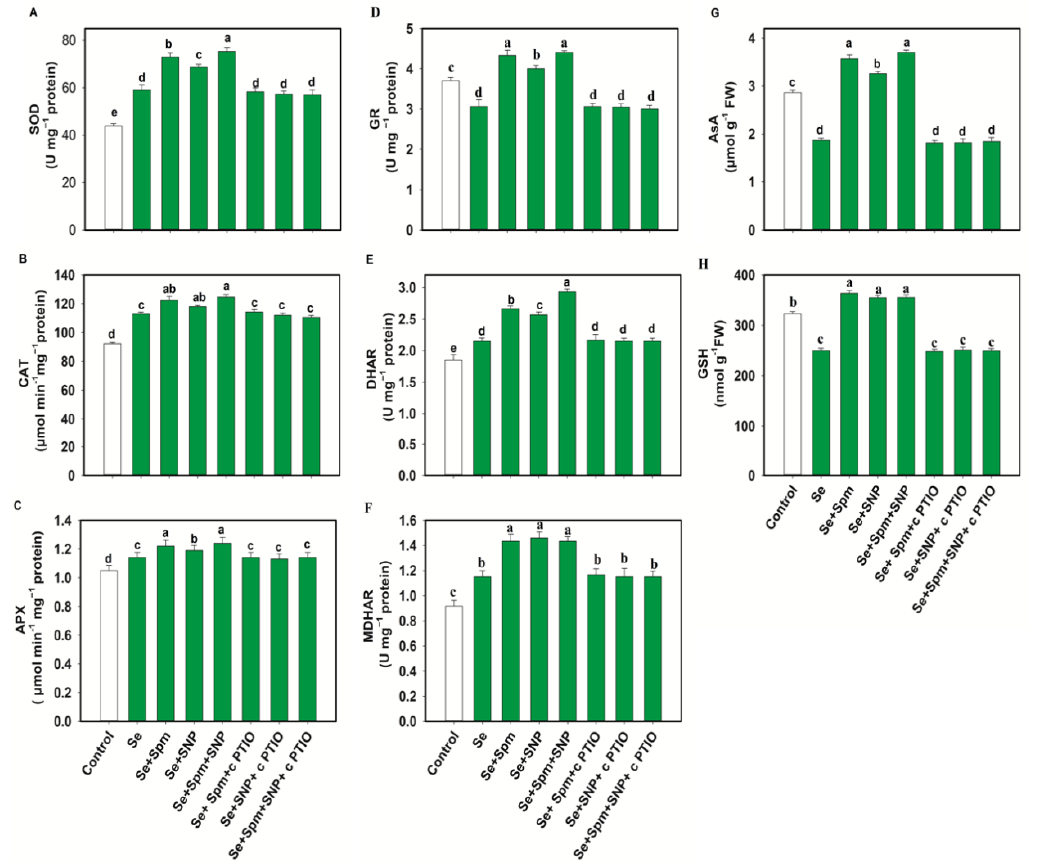
Figure 6. Superoxide dismutase (SOD) ( A ), catalase (CAT) ( B ), ascorbate peroxidase (APX) ( C ), glutathione reductase (GR) ( D ) dehydroascorbate reductase (DHAR) ( E ) and monodehydroascorbate reductase (MDHAR) ( F ) activities and ascorbate (AsA) ( G ) and glutathione (GSH) ( H ) levels in leaves of 49-day-old wheat plants grown under control and Se stress (1 mM) sprayed with 1.0 mM Spm or 0.1 mM SNP alone or together, combined with 0.1 mM cPTIO, a NO scavenger. Data presented are the mean (± SE) of three replicates, and bars with dissimilar letters (a–e) represent significantly different results at the p ≤ 0.05 level based on Fisher’s LSD test.